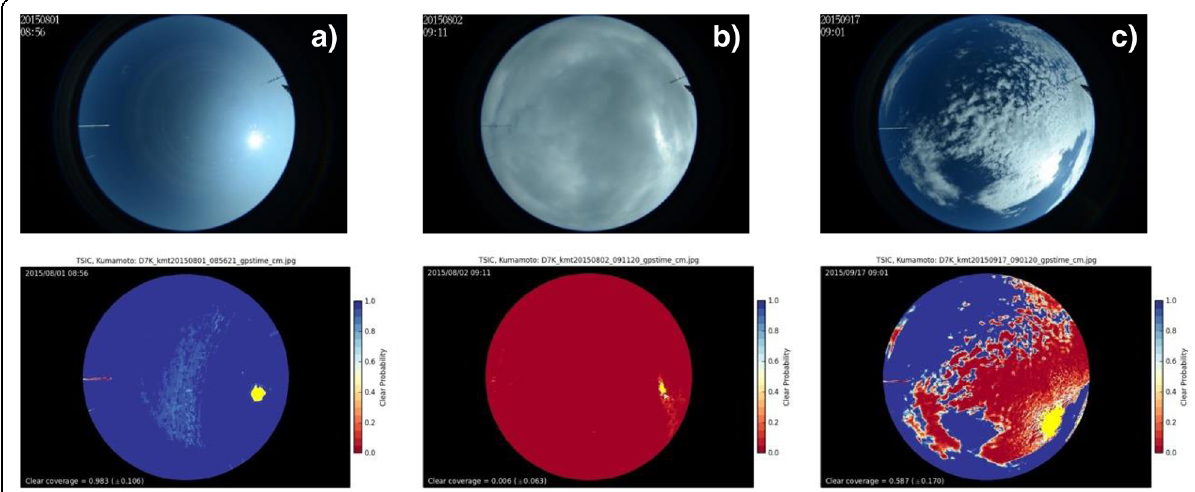
Fig. 10 Examples of raw sky camera images (upper images) and analyzed sky camera images (lower images) for a completely clear sky, b completely cloudy sky, and c a mixed clear/cloudy